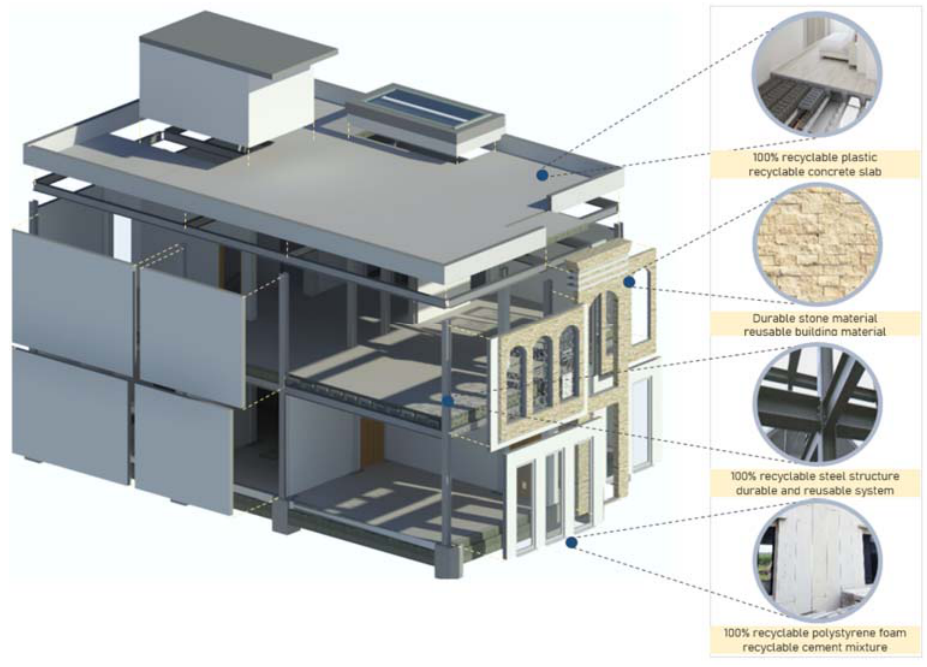
Figure 12. 7D BIM Application: Deconstruction Theme.